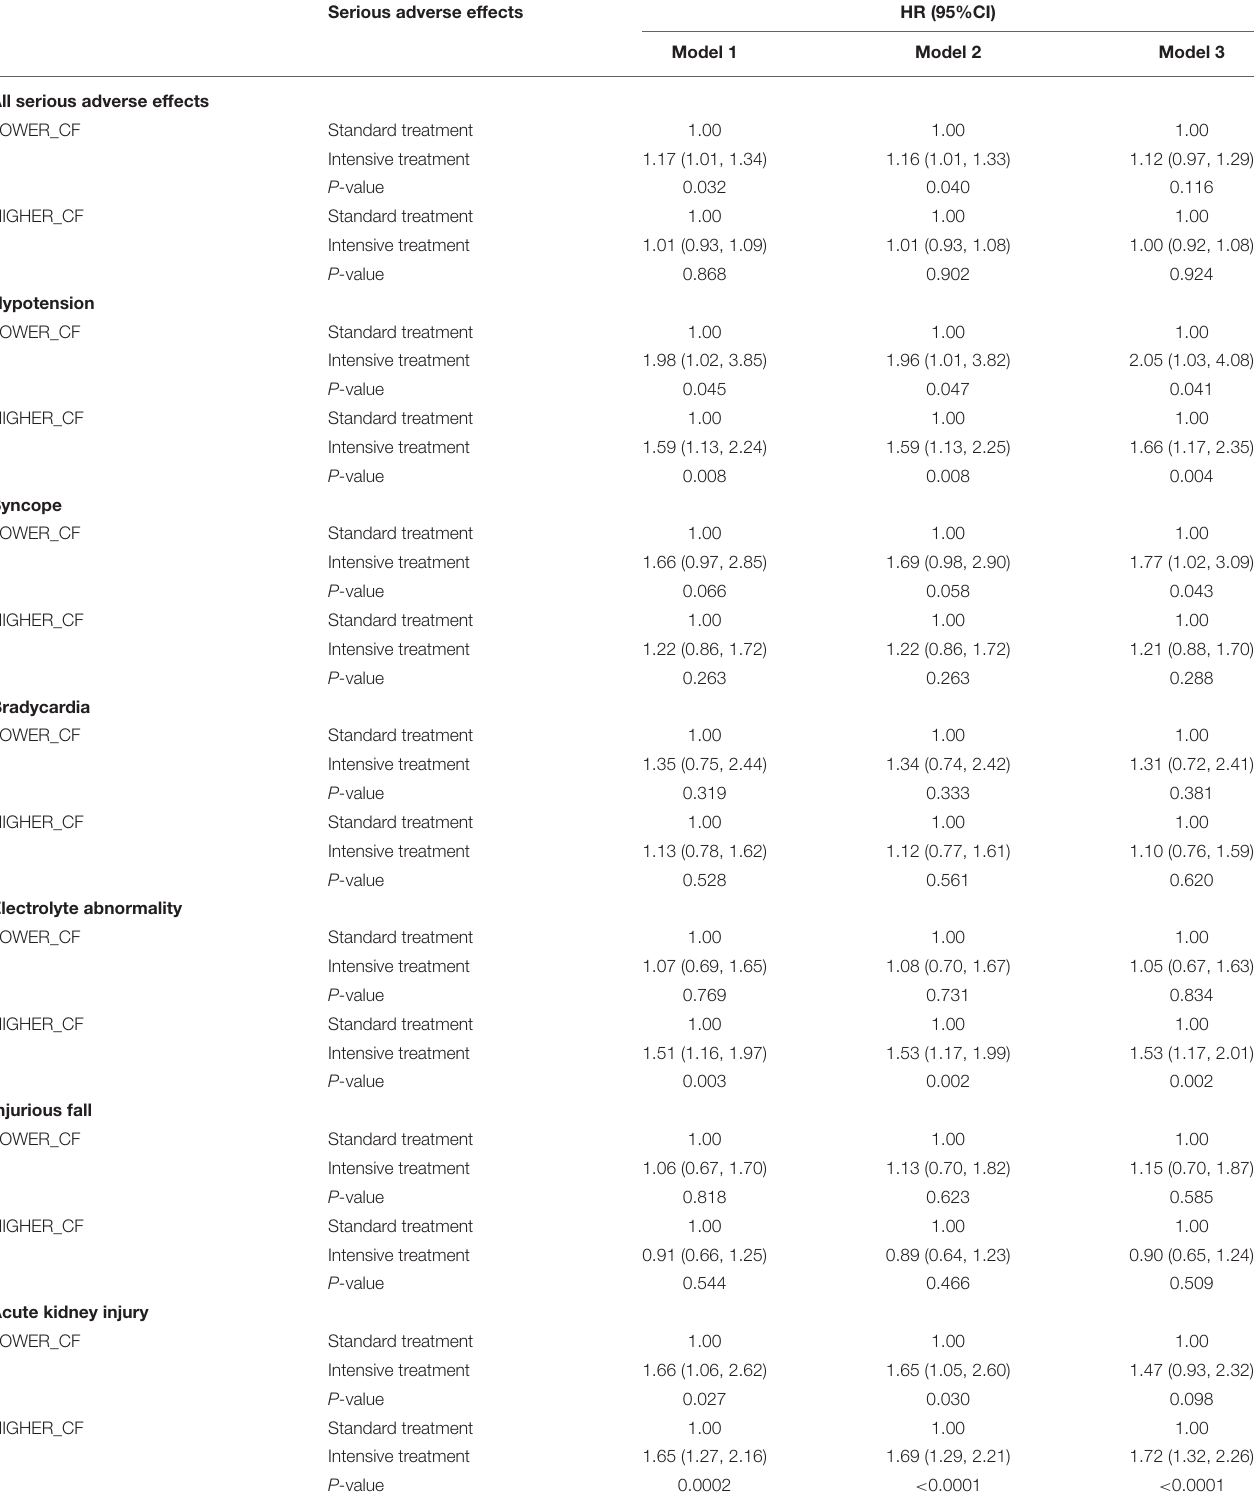
TABLE 3 | Serious adverse effects by treatment arm and baseline cognitive